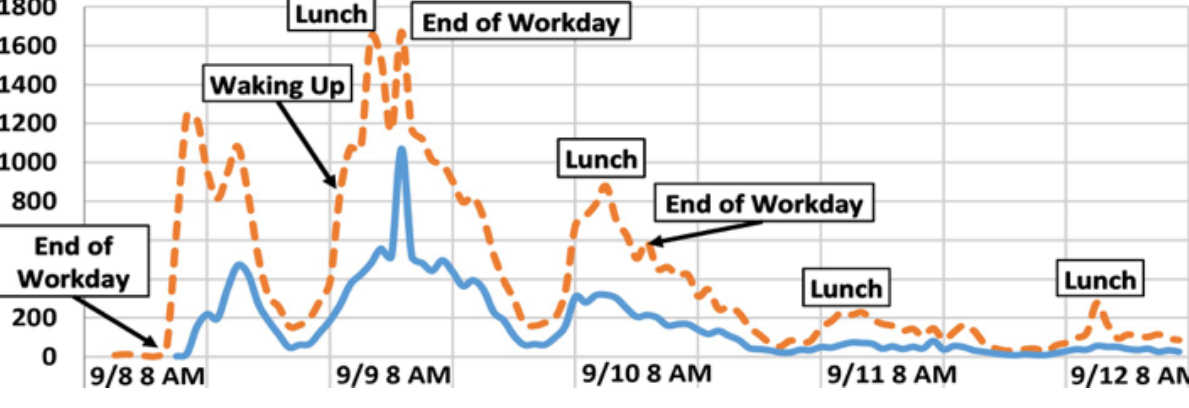
Figure 1. Counts per hour of #WhyIStayed (dotted) or #WhyILeft (solid) tweets from 9/8 to 9/12. Times in Eastern Standard Time, vertical lines mark 12-hour periods, with label corresponding to its left line. We removed spam from this set, but not meta